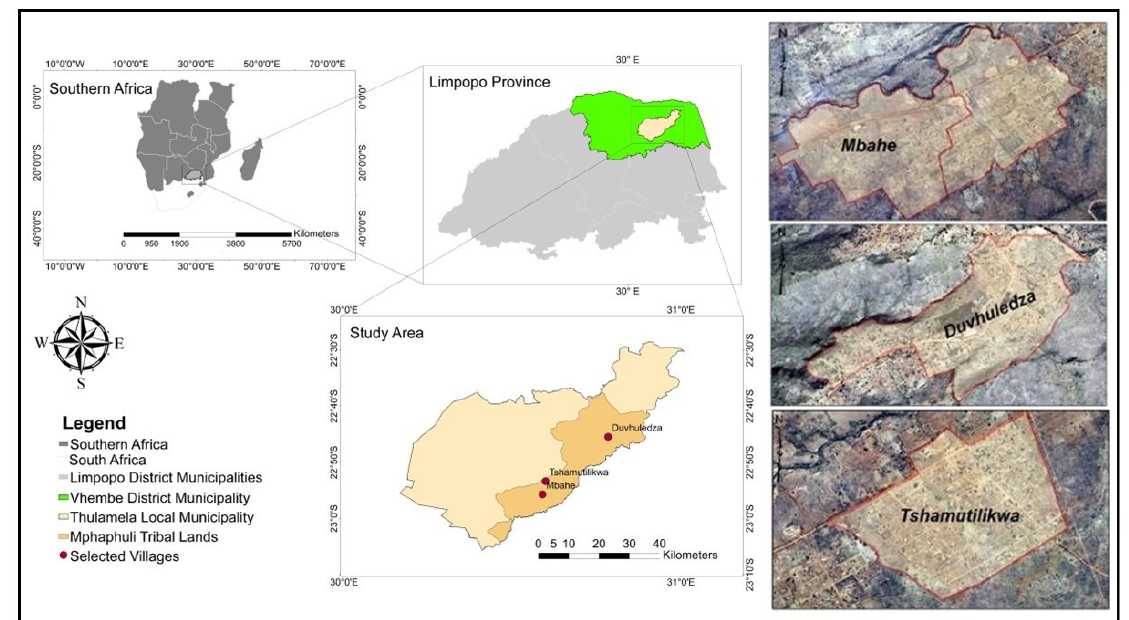
Figure 1. A map of the study site.